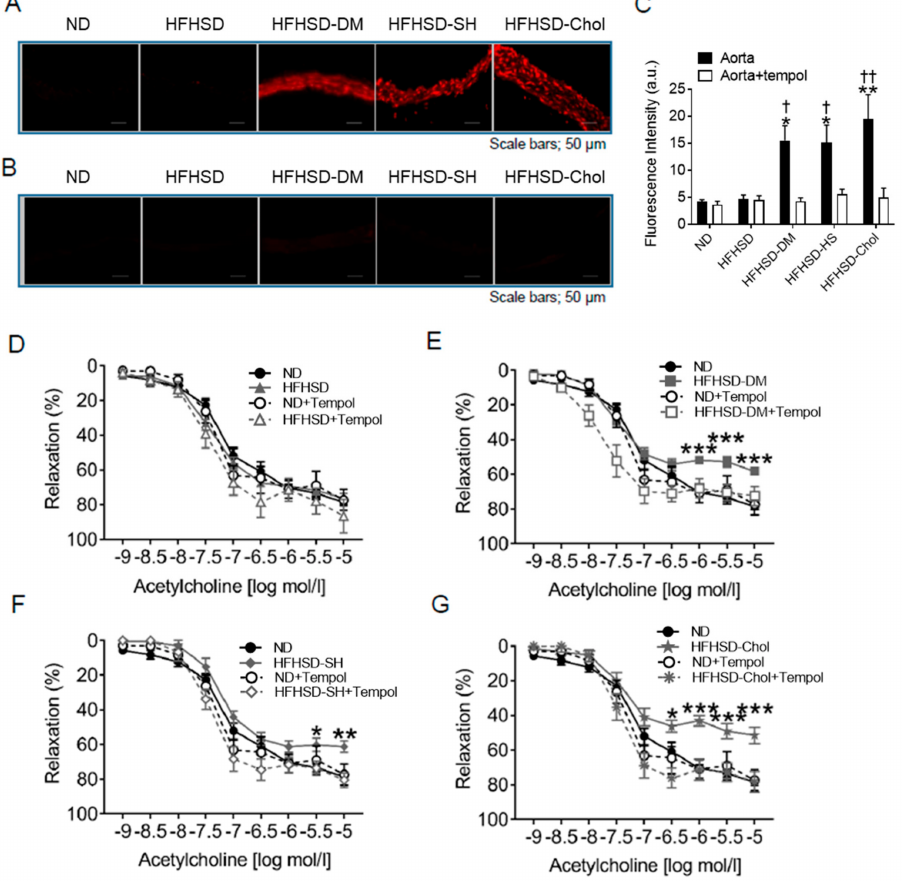
Figure 3. Endothelial-dependent relaxation in the HFHSD-DM, HFHSD-SH, and HFHSD-Chol groups was significantly impaired and accompanied by increased superoxide production from aortas without PVAT: ( A ) DHE staining of aortic rings and ( B ) aortic rings with tempol; ( C ) quantification of DHE fluorescence (n = 8 for each group). Vascular relaxation of aortic rings with acetylcholine in the HFHSD group ( D ), HFHSD-DM group ( E ), HFHSD-SH group ( F ), and HFHSD-Chol group ( G ) com- pared with the ND group (ND, n = 16; HFHSD, n = 12; HFHSD-DM, n = 12; HFHSD-SH, n = 16; HFHSD-Chol, n = 14). Acetylcholine indicates acetylcholine; DHE, dihydroethidium; ND, normal diet group; HFHSD, high-fat/high-sucrose (HFHSD) diet group; HFHSD-DM, HFHSD group that received streptozocin (STZ) (50 mg/kg/day for 2 days at 20 weeks old); HFHSD-SH, choline-deficient HFHSD group; HFHSD-Chol, 1% cholesterol, and 0.1% deoxycholic acid-containing HFHSD group. Error bars represent the standard error of the mean (SEM). * p < 0.05, ** p < 0.01, and *** p < 0.001 compared with the ND group and † p < 0.05 and †† p < 0.01 compared with aorta without treatment of